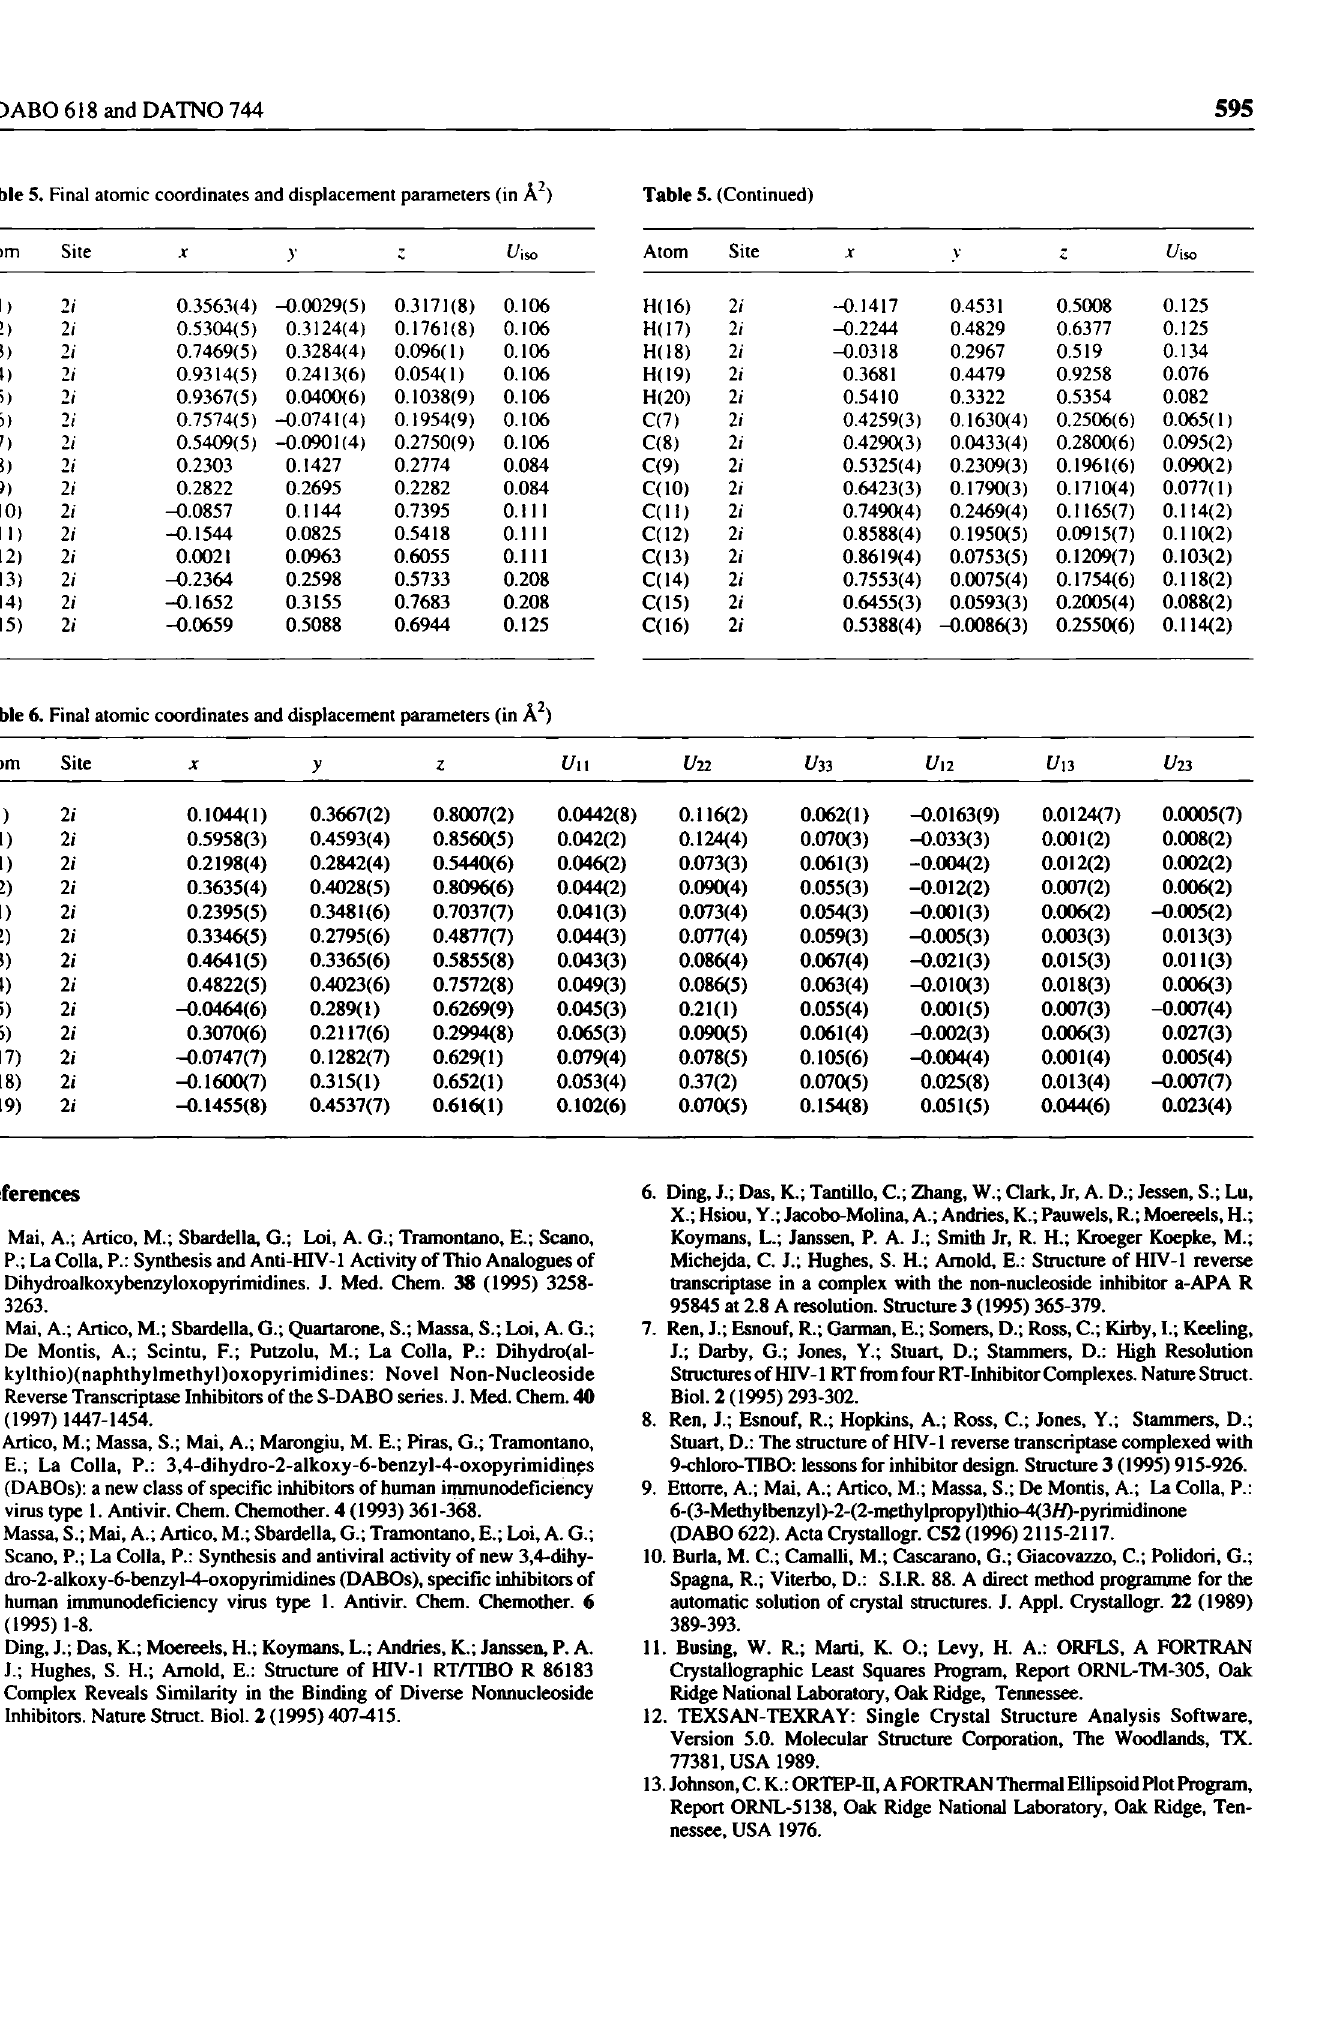
Table 5. Final atomic coordinates and displacement parameters (in Л^) Table 5. (Continued)